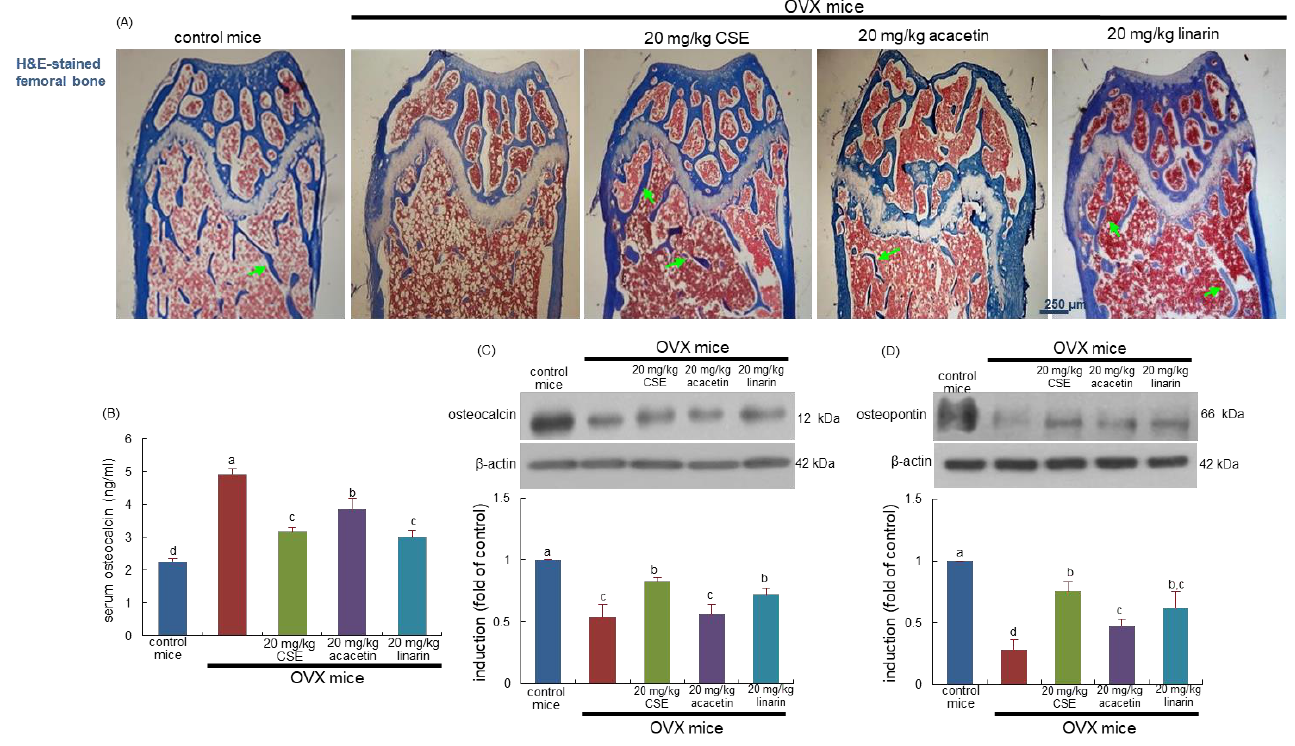
Figure 5. Effects of Cirsium setidens water extracts (CSEs), acacetin, or linarin on histology of trabecular bones ( A ), serum level of osteocalcin ( B ), and bone tissue levels of osteocalcin ( C ) and osteopontin ( D ) in ovariectomized (OVX) mice. OVX mice were orally supplemented with 20 mg/kg CSEs, 20 mg/kg acacetin, or 20 mg/kg linarin daily for 8 weeks. For the observation of trabecular bone and epiphyseal plate ( A ), longitudinal sections of femoral bone tissue were hematoxylin and eosin (H&E)-stained. Images were visualized using light microscopy (four separate experiments). Green arrows indicate the formation of trabecular bones. Scale bar = 250 µ m. The serum level of osteocalcin was measured by employing an enzyme-linked immunosorbent assay kit ( B ). Whole bone tissue extracts were subjected to SDS-PAGE and Western blot analyses with specific antibodies against osteocalcin ( C ) and osteopontin ( D ). β -Actin was used as internal control. The bar graphs (mean ± SEM) in the right panels represent quantitative results obtained using a densitometer. Values in bar graphs not sharing a small alphabetical letter are different at p < 0.05.